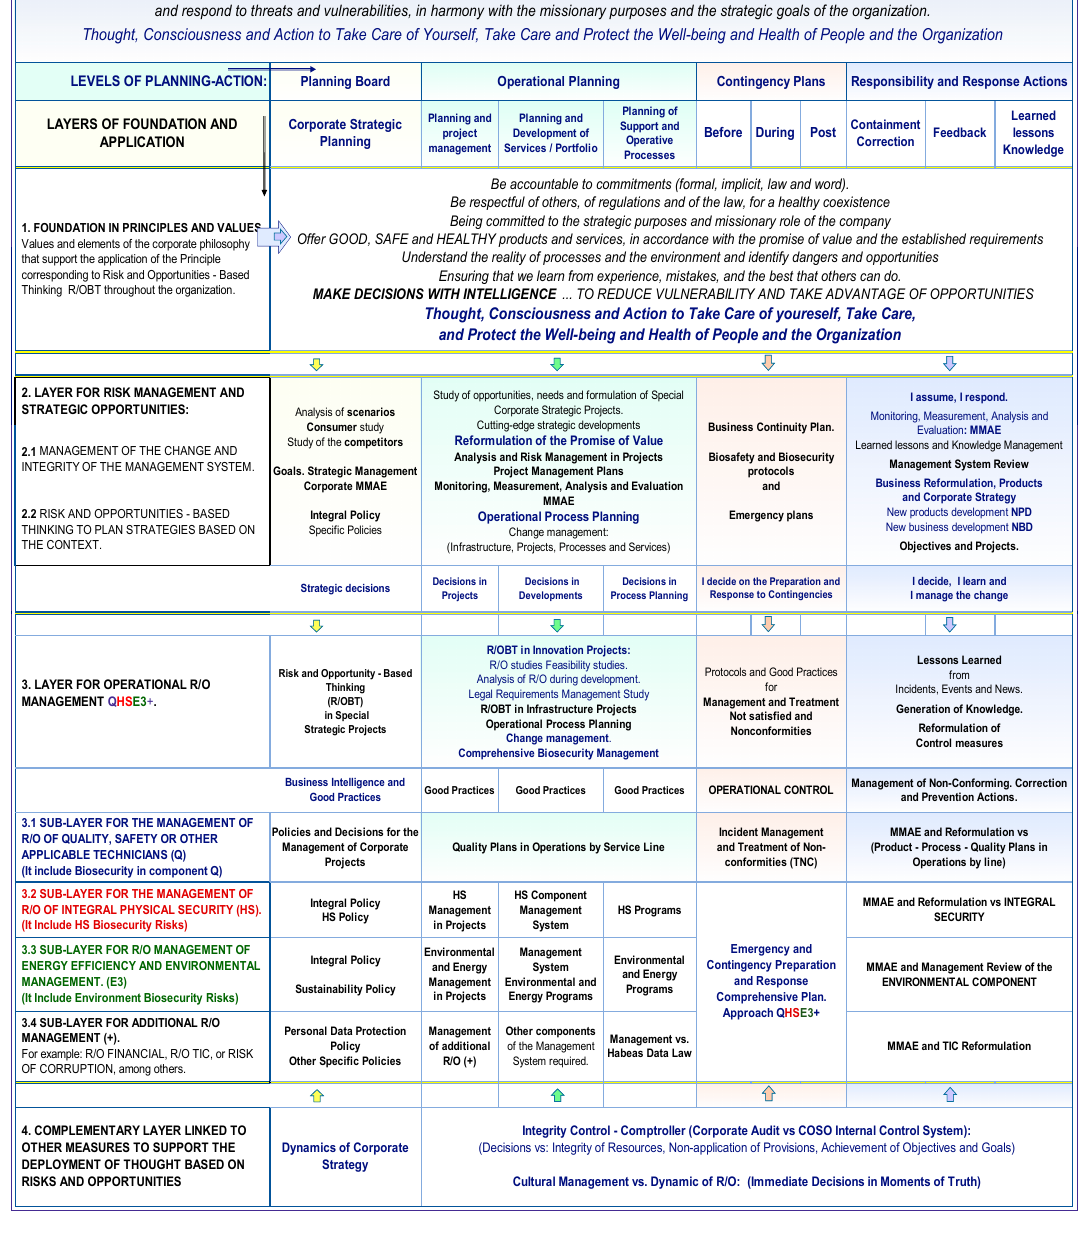
Figure 8. Functional matrix of comprehensive R/O management model layers and levels.